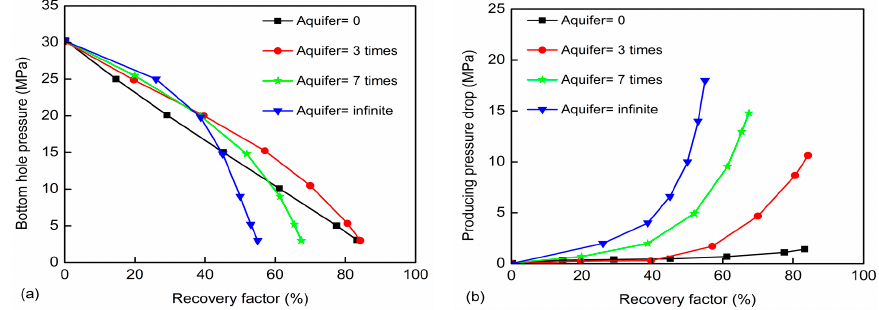
Figure 4. Bottom hole pressure and producing pressure drop versus recovery factor for different aquifers. ( a ) Bottom hole pressure; ( b ) producing pressure drop.